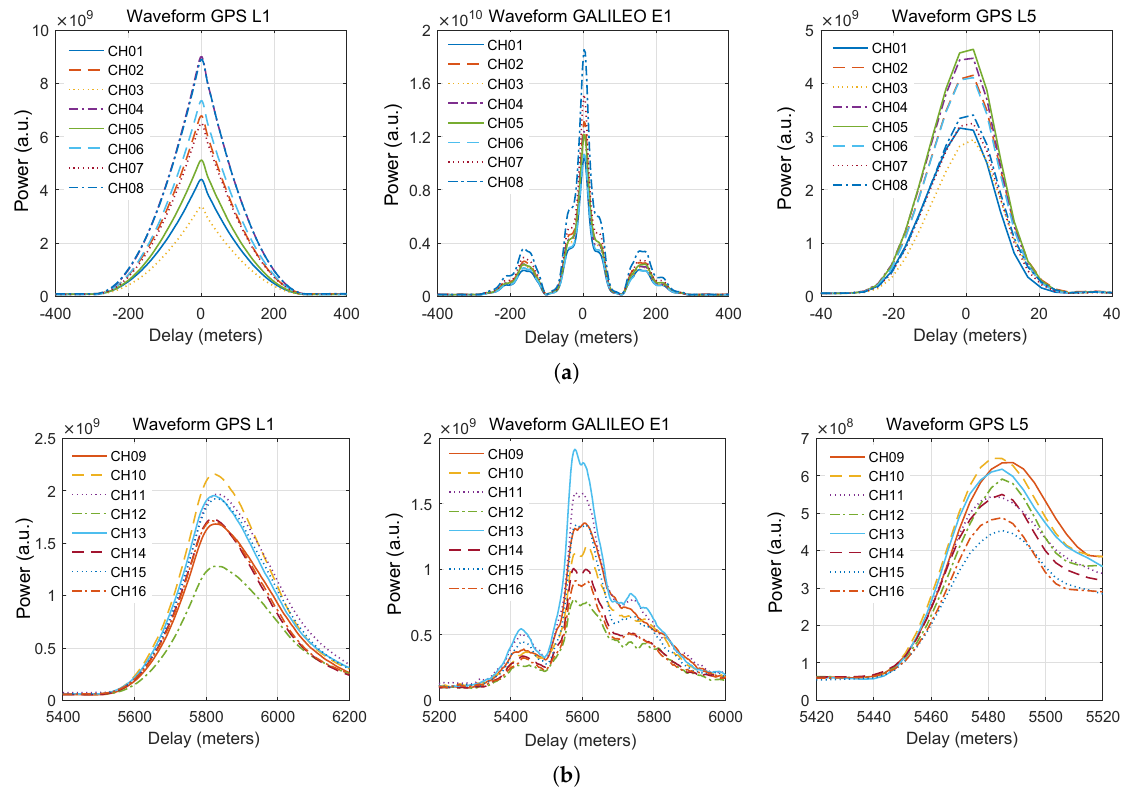
Figure 13. Clean-replica power-waveform examples by channels. ( a ) Power-waveforms of the up-looking channels (CH01 ∼ CH08). From left to right: GPS L1 (SNR = 16.9 ∼ 20.1 dB), GALILEO E1 (SNR = 19.4 ∼ 21.1 dB), and GPS L5 (SNR = 17.4 ∼ 19.0 dB). ( b ) Power-waveforms of the down-looking channels (CH09 ∼ CH16). From left to right: GPS L1 (SNR = 13.3 ∼ 15.3 dB), GALILEO E1 (SNR = 8.6 ∼ 12.4 dB), and GPS L5 (SNR = 8.9 ∼ 10.2